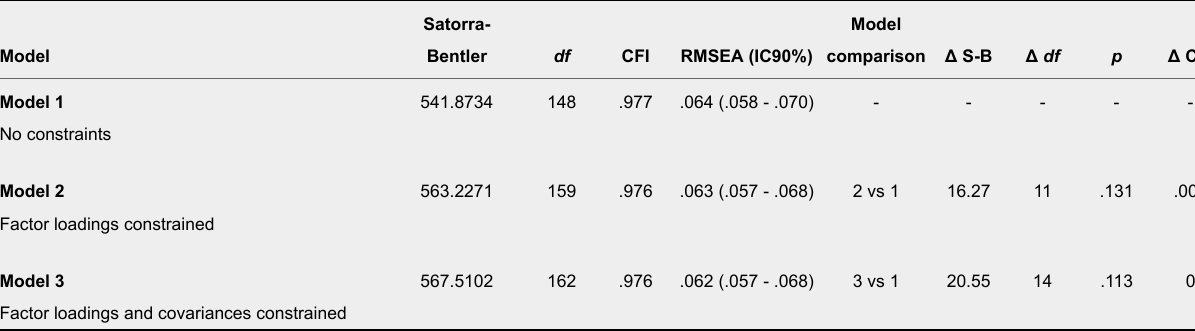
MHC-SF. Factorial Invariance Across Sex (Males vs. Females).